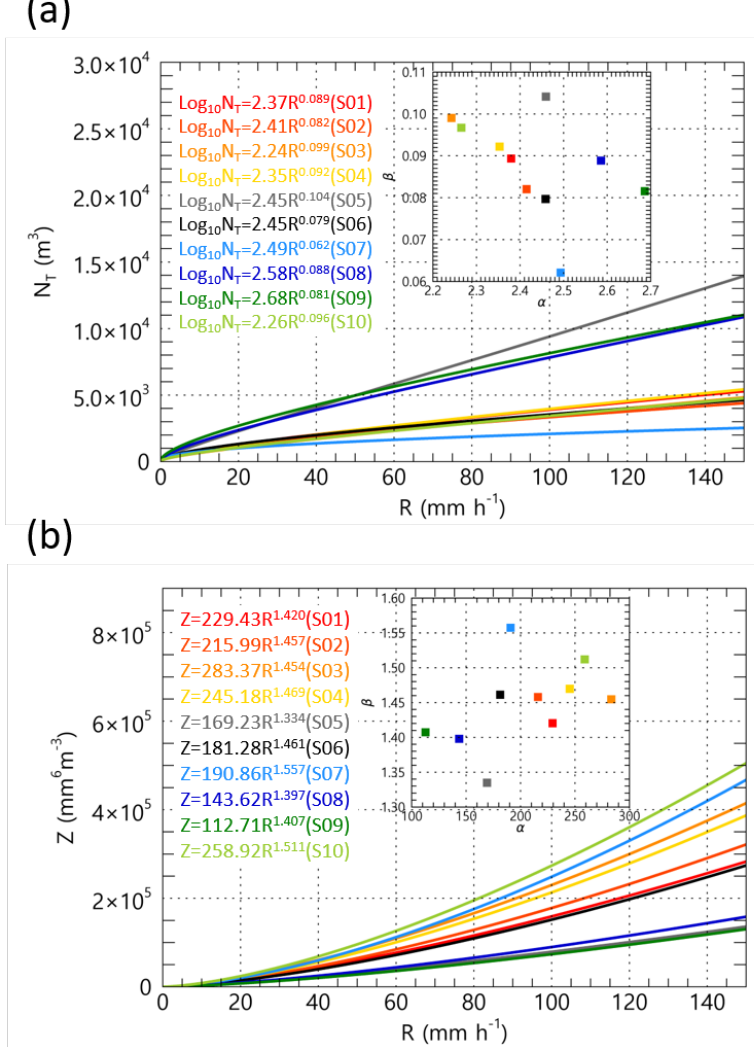
Figure 14. The fitting lines for ( a ) N T versus rain rate, and ( b ) reflectivity versus rain rate. The inside graphs show the parameters of the relationships. The colored solid lines indicate each Parsivel site.